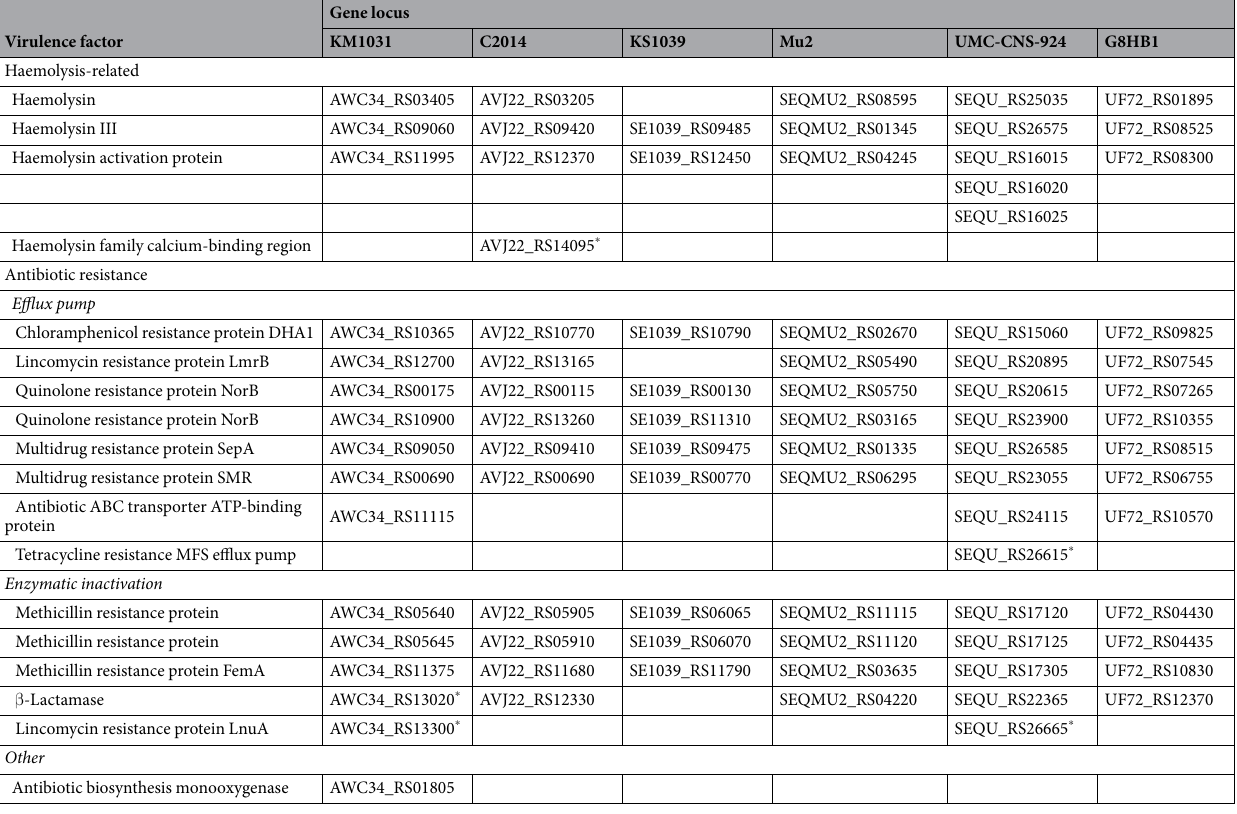
Table 2. Potential virulence determinants identified in six S . equorum genomes. * Genes located in a